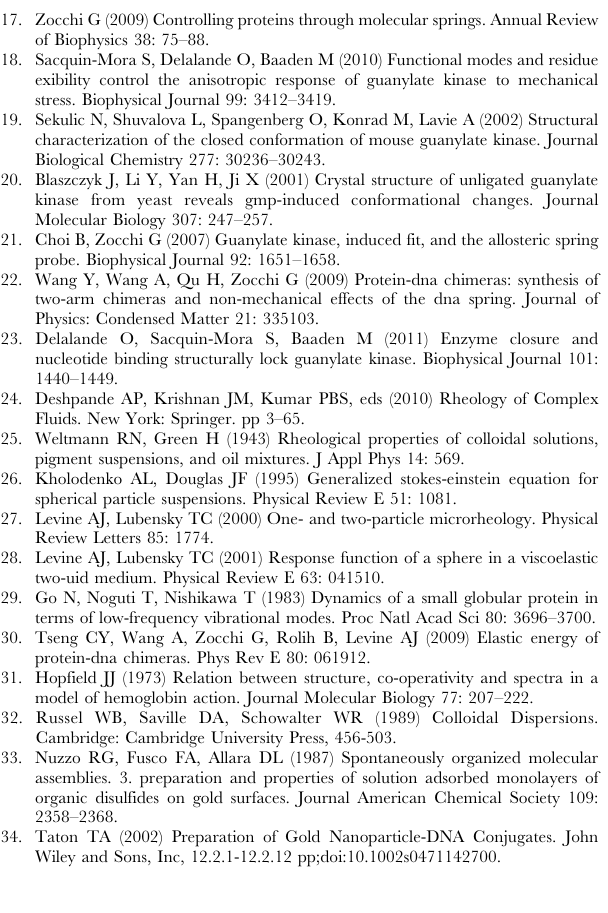
Figure S7 Calculated real and imaginary parts of the complex modulus. We represent the same data and fits of Fig. 2 in terms of storage modulus G 0 v ð Þ and loss modulus G 00 v ð Þ calculated from (eqs. 18 { 21 ), since this is the canonical representation in the rheological literature. The squares are consistent with purely elastic behavior of the protein, the circles with viscoelastic behavior [24]. Specifically, G 0 v ð Þ is constant in the elastic regime while it drops at low frequency in the viscoelastic regime (the low frequency drop is sometimes referred to as the Maxwell transition [24] and is the signature of viscoelasticity). (a) The storage modulus G 0 v ð Þ (the real part of the complex modulus, arbitrary unit) of the protein in the elastic (squares) and viscoelastic